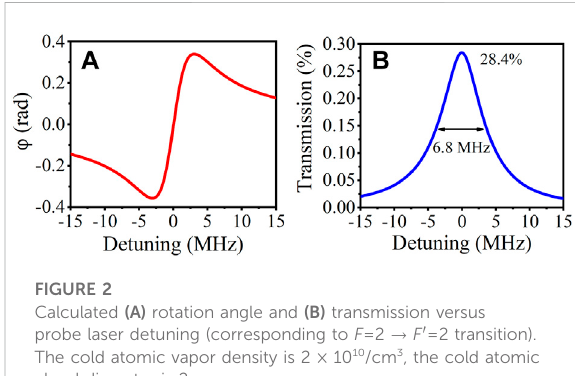
FIGURE 2 Calculated (A) rotation angle and (B) transmission versus probe laser detuning (corresponding to F =2 → F ′ =2 transition). The cold atomic vapor density is 2 × 10 10 /cm 3 , the cold atomic cloud diameter is 2 mm.